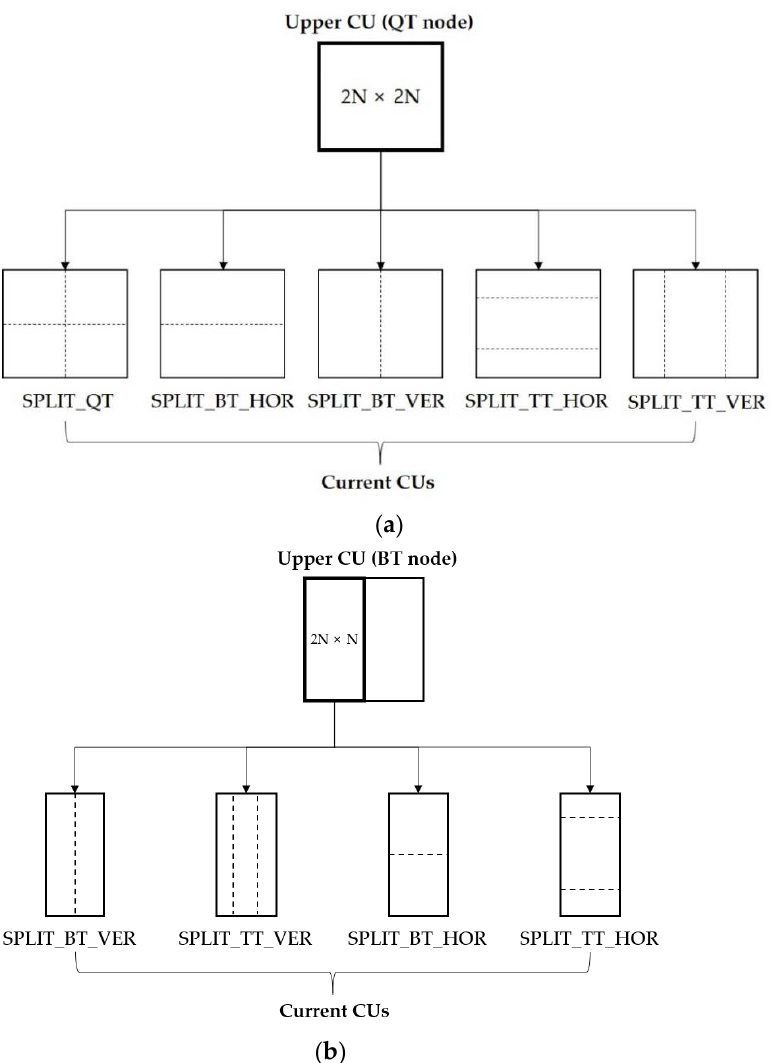
Figure 2. Relations between an upper CU and current CUs: ( a ) Example of QT node as upper CU; ( b ) Example of MTT node as upper CU.